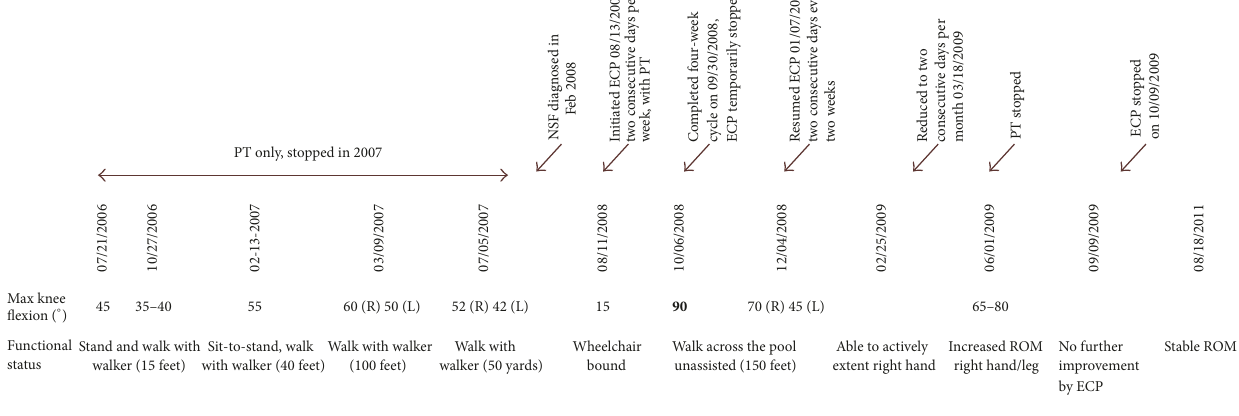
Figure 2: Disease and treatment timeline.